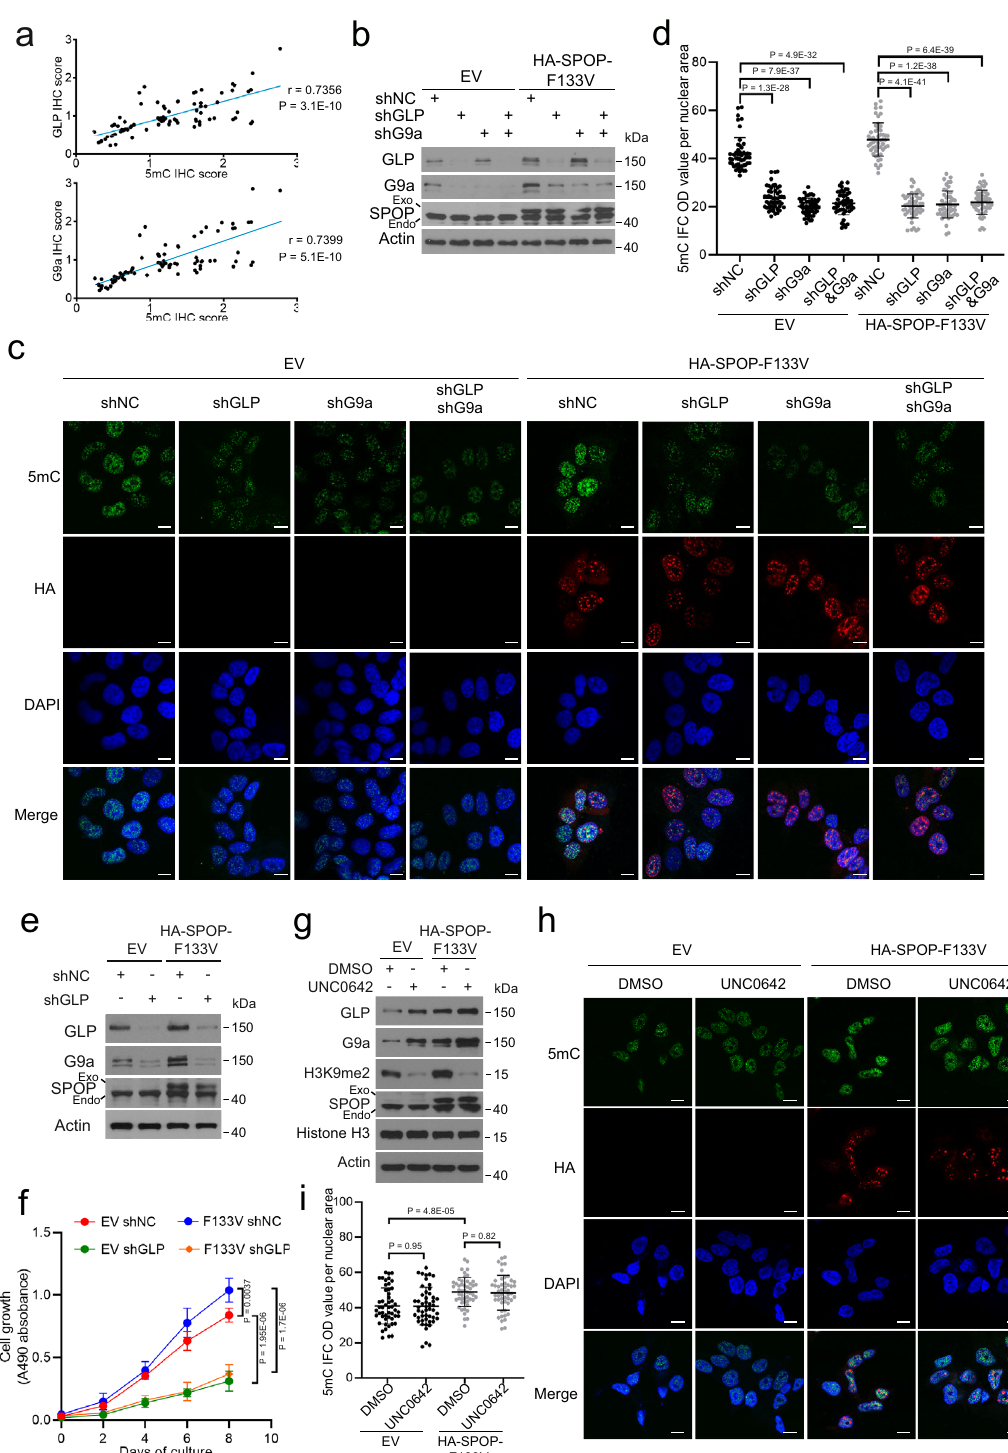
Fig. 4 GLP/G9a mediate SPOP mutation-induced hypermethylation independent of its HMTase activity. a Pearson correlation of 5mC and